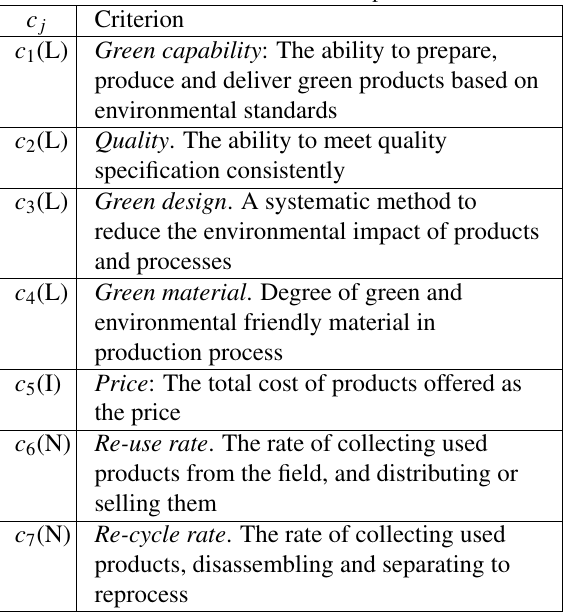
Table 1. Criteria set description.